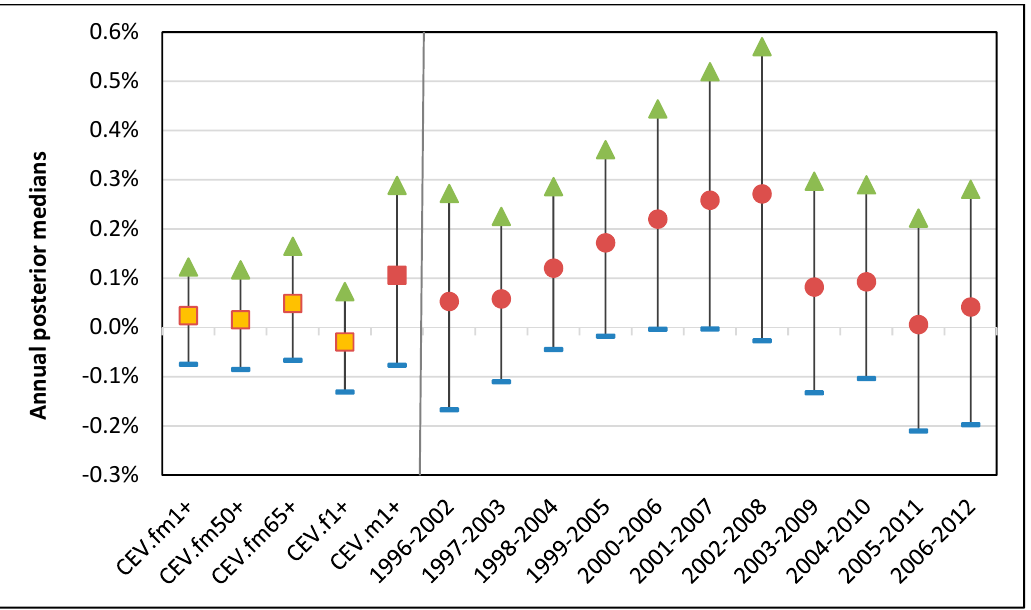
Figure 9. A total of 95% posterior intervals for the associations per 10 ppb 1-day lagged ozone with CEV hospitalizations for warm season: ( a ) 17 years combined risks for 5 groups (squares); ( b ) 11 annual risks of males (circles in red).